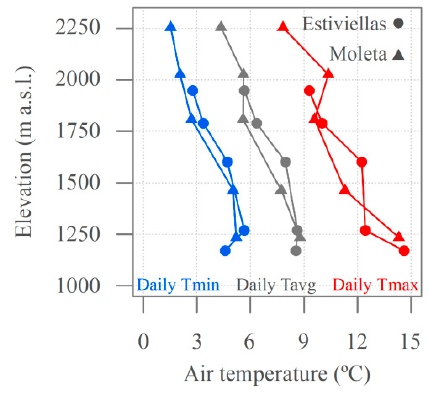
Figure 3. Mean daily maximum ( Tmax ), minimum ( Tmin ) and average ( Tavg ) air temperatures in the ten locations during the study period.